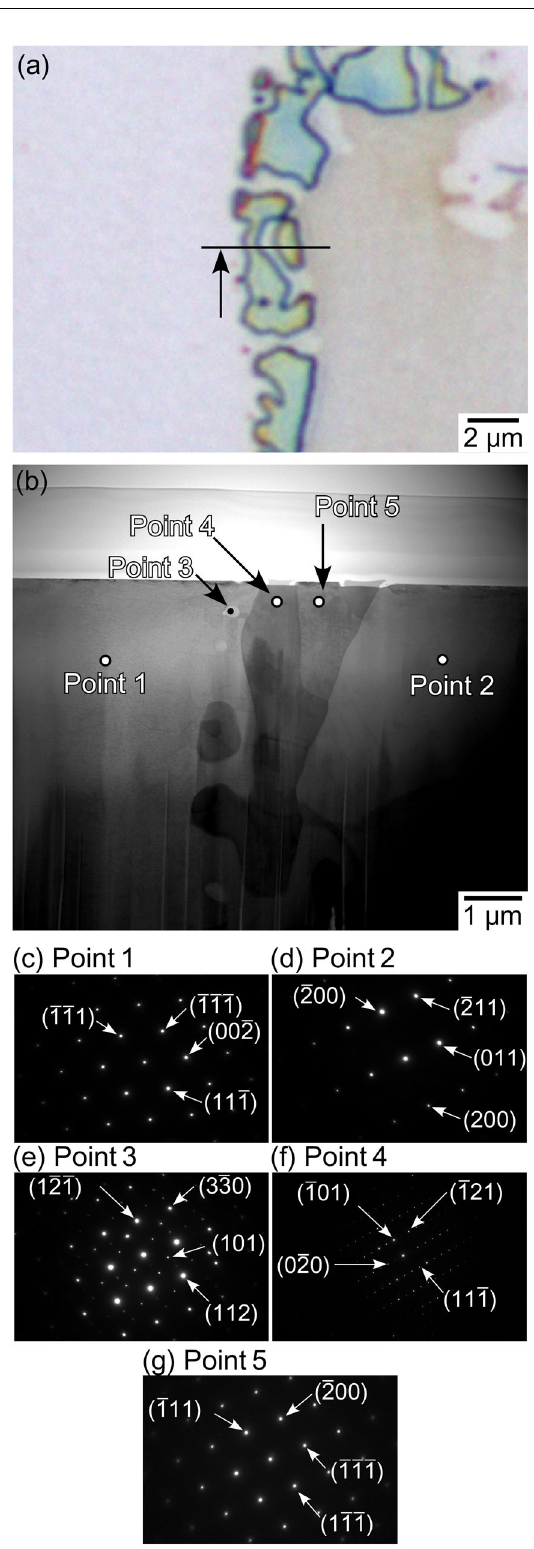
Fig. 5 An α and γ phase boundary region of the aged specimen. a Optical micrograph of a boundary between the α and γ phases of the aged specimen after etching. b STEM bright fi eld image of the cross-section along the black line shown in a . STEM observation was made from the direction of the arrow in a . c – g Electron diffraction patterns at c Point 1, d Point 2, e Point 3, f Point 4, and g Point 5 shown in b